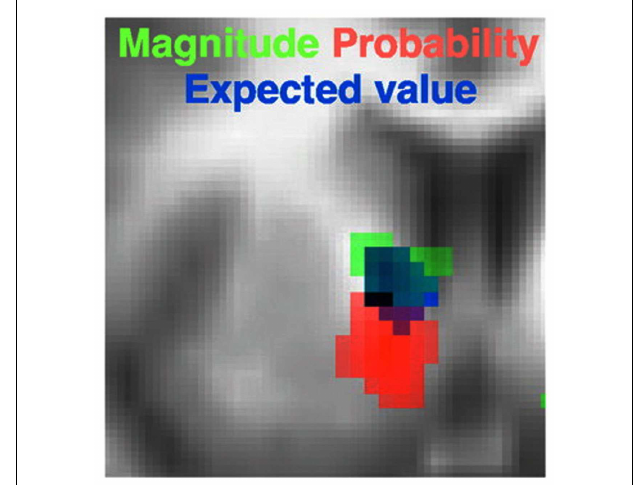
FIGURE 4 | Separate and partially overlapping striatal regions encoding unique valuation components of probabilistic rewards. Activity in dorsal striatum positively correlated with U (in this case magnitude), and in ventral striatum with probability.Their product, that is expected utility, positively correlated with a third, and overlapping striatal region. Figure adapted fromTobler et al.